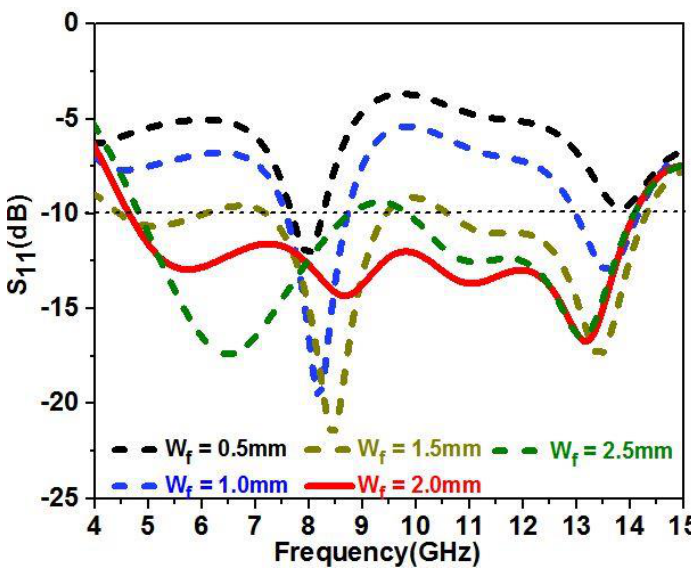
Figure 10. Parametric analysis for variation in W f for S 11 .